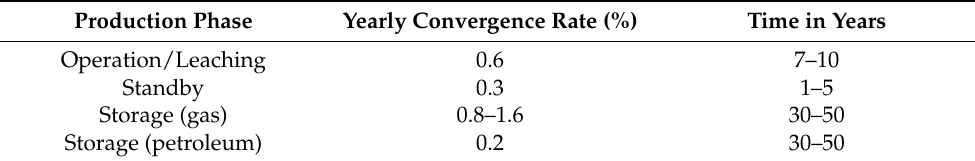
Table 2. List of average values of convergence rate